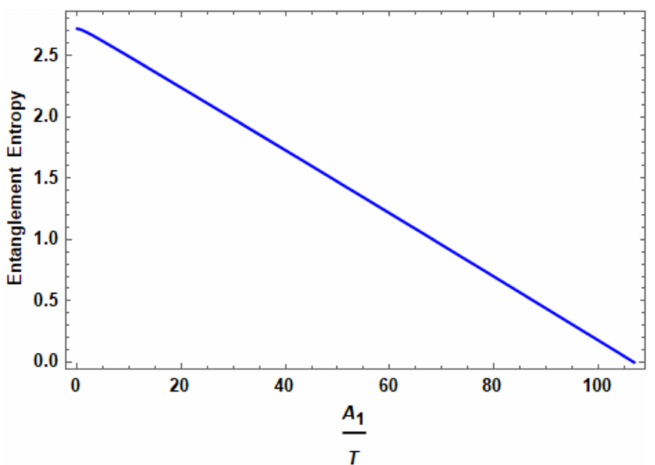
Figure 12. A representative plot of the entanglement entropy, as defined by ∆ S , for a sub-region that consists of two copies of the half-space on two sides of the TFD-state. In this particular case, we have set the boundary time t b = 0 for convenience. We have shown the dependence of the renormalized entanglement entropy as a function of the deformation parameter, a la equation (4.10) in the toy